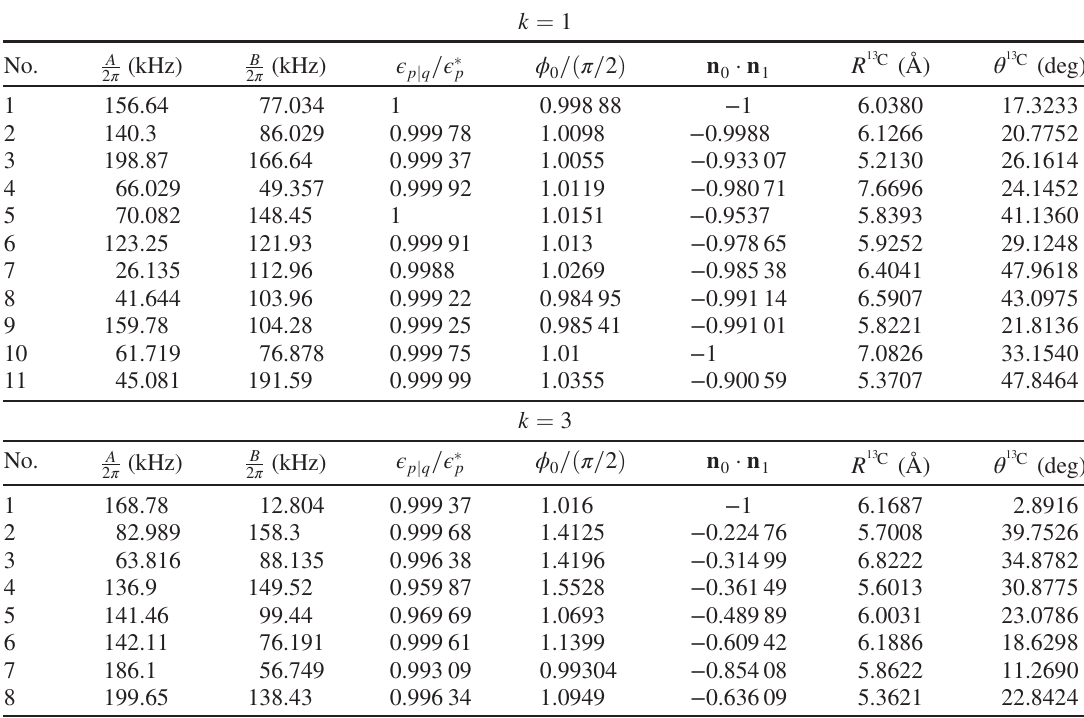
TABLE III. Parameters for the k ¼ 1 UDD 3 resonance in Figs. 6(e) and 6(f) and the k ¼ 3 UDD 3 resonance in Figs. 6(g) and 6(h).